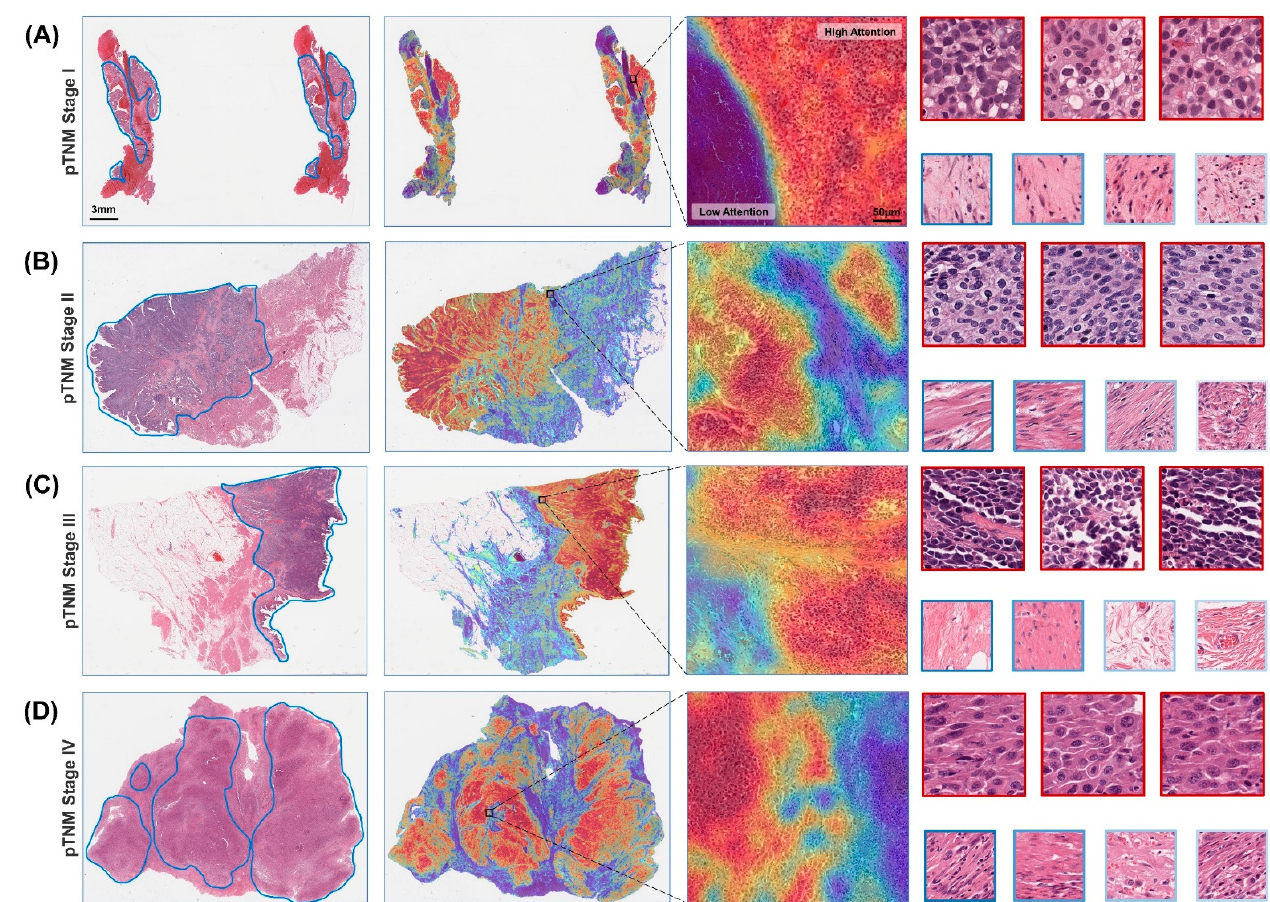
Figure 4. Heatmaps of the diagnostic model on WSIs at different pathological stages. A representative WSI for each pathological stage was annotated by a uropathologist who roughly delineated the tumor tissue area (first column), including ( A ) AJCC TNM stage I, ( B ) stage II, ( C ) stage III and ( D ) stage IV. The attention scores of the predicted categories of patches are calculated by the model, and the attention heatmap corresponding to each WSI was generated and overlaid onto it (second column). It is then further zoomed in to show the heatmap of the ROI, highlighting the tumor and normal borders (third column). Patches with the highest attention (red border) often exhibit well- known tumor morphology, while patches of low interest (blue border) tend to be normal tissue or background (fourth column).